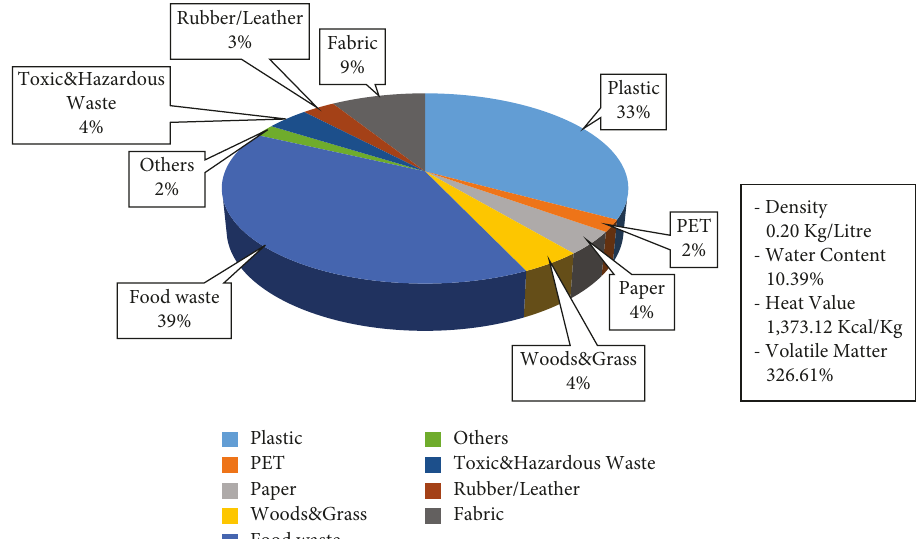
Figure 2: Composition and characteristics of waste in Bantargebang landfill.